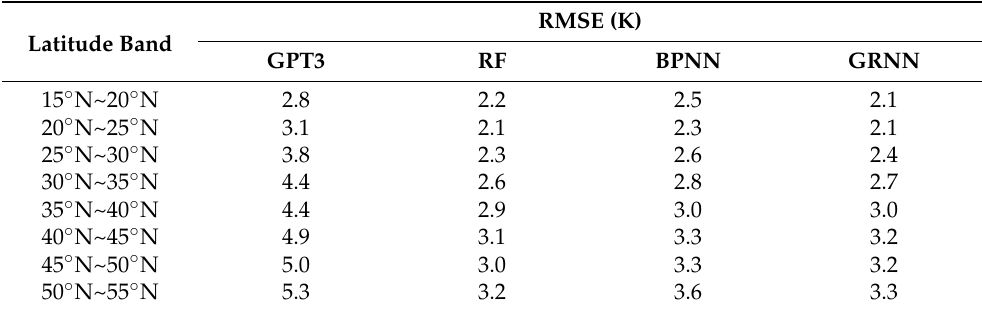
Table 2. Root mean square errors of different models at different latitude bands.